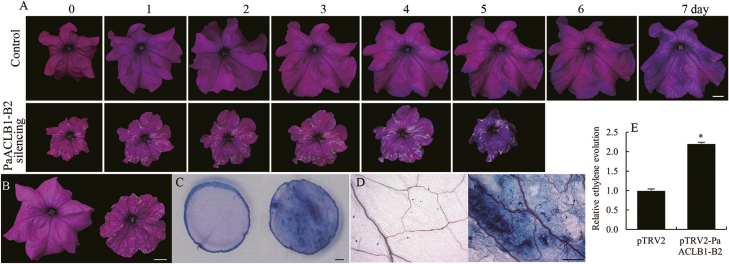

PaACLB1-B2 silencing accelerates flower senescence in petunia. (A) Flowers of PaACLB1-B2-silenced and control plants. (B) Corollas for trypan blue dyeing. (C, D) Corolla tissues after trypan blue dyeing. (E) Ethylene production in PaACLB1-B2-silenced and control corollas. *P≤0.05. Bars=1 cm in (A) and (B); 0.1 cm in (C); 500 μm in (D).